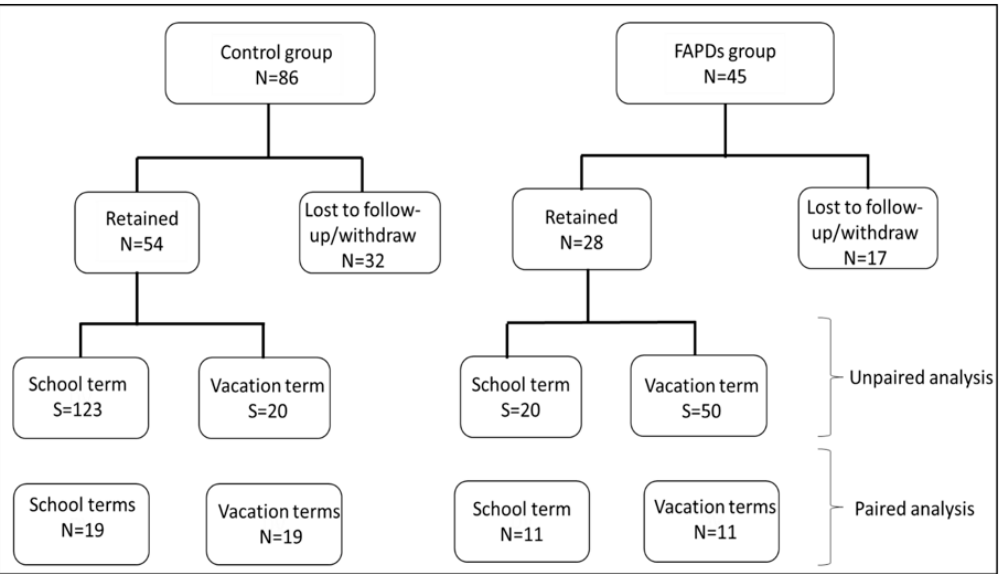
Figure 1. The flowchart of the participants in the study. The chart illustrates the total participants per group, loss of follow-up or withdrawal from the study, and retained patients. The analysis was separately performed on the unpaired and paired samples in every group. N denotes number of participants, while S denotes number of stool samples.